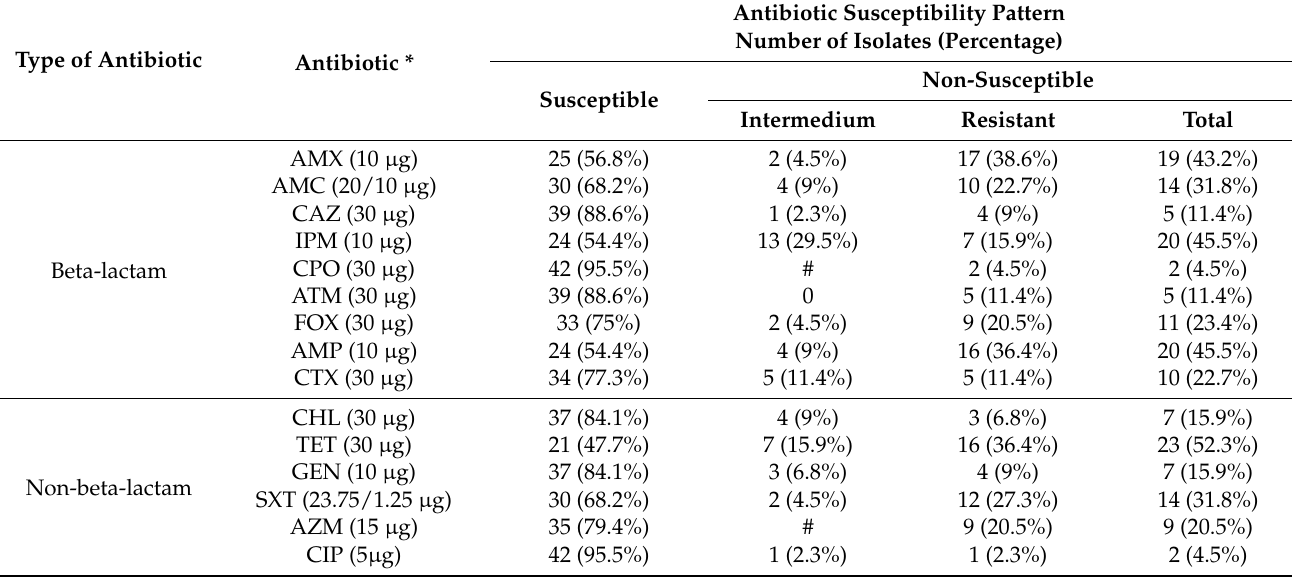
Table 6. Antibiotic resistance profiles of 44 isolates of Enterobacteriaceae (28 isolates of E. coli and 16 isolates of Klebsiella spp.).